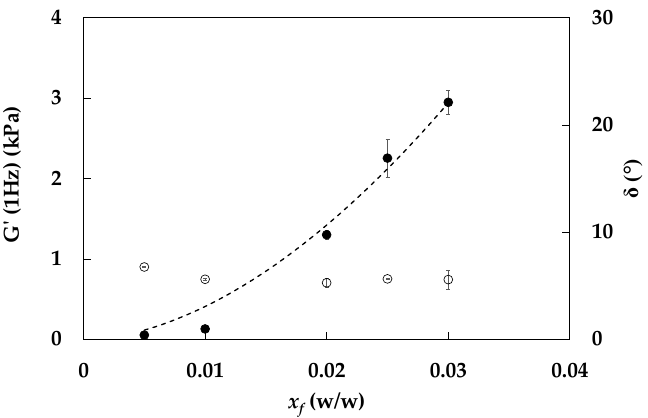
Figure 2. Storage modulus G ′ (1 Hz, full symbols) and phase angle δ (°, open symbols) of fiber suspensions as a function of fiber fraction. Experimental data (full symbols) and fractal model fitting of G ′ (dashed line, Equation (4)).